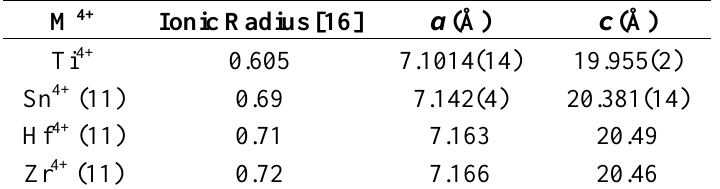
Table 1. Lattice parameters (and Shannon radii) for the title compound and the three other